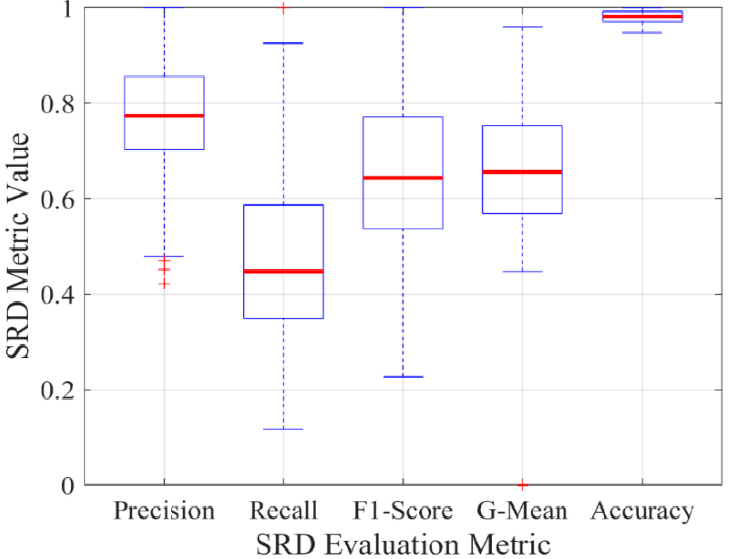
Figure 10. Evaluation results for SRD performances of proposed method for 122 specular reflected images (121 sub-aperture + 1 maximum) × 18 objects = 2196 images for all objects (O#1–O#18) combined using different SRD metrics.